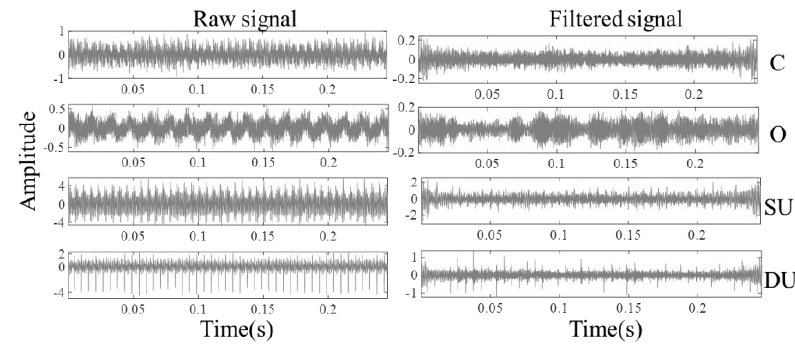
Figure 9. Experimental results with statistical filter.